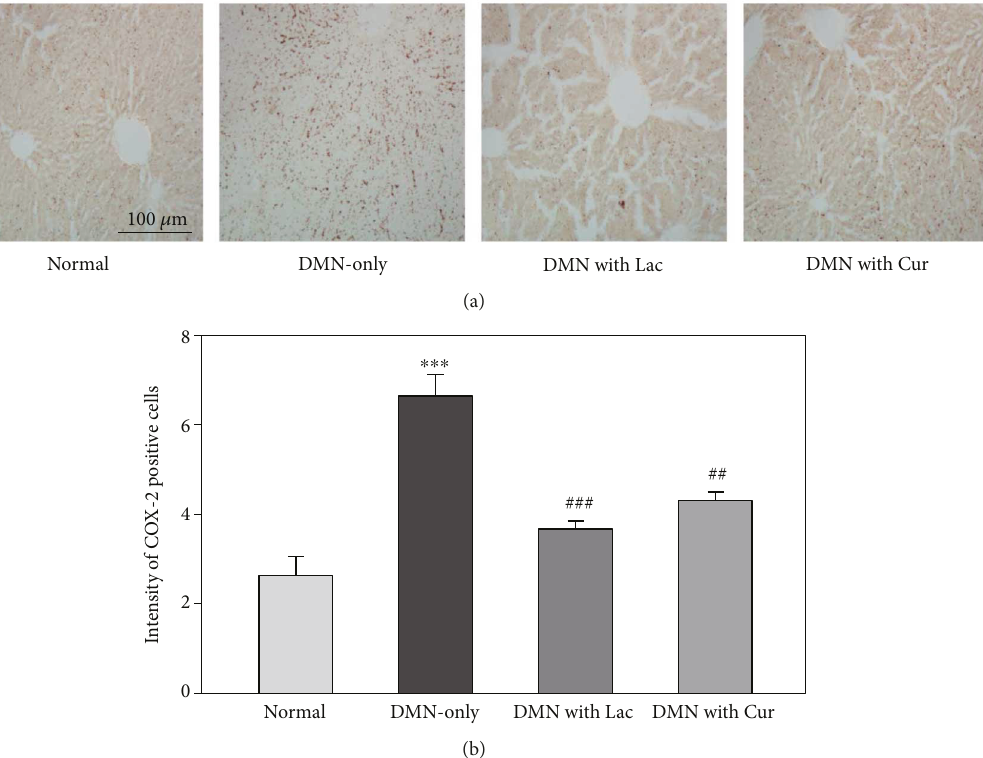
Figure 6: E ff ect of curcumin on COX-2 expression in liver tissue. (a) Representative photographs showing immunostained COX-2 in rat liver. (b) Positive cell count showing expression of COX-2 in rat liver tissue. Data are represented by mean ± SEM ( n = 6 in each group). Statistical signi fi cances are compared between the normal and DMN-only groups ( ∗∗∗ p < 0 001 ) or between the DMN-only and DMN with treatment groups ( ## p < 0 01 ; ### p < 0 001